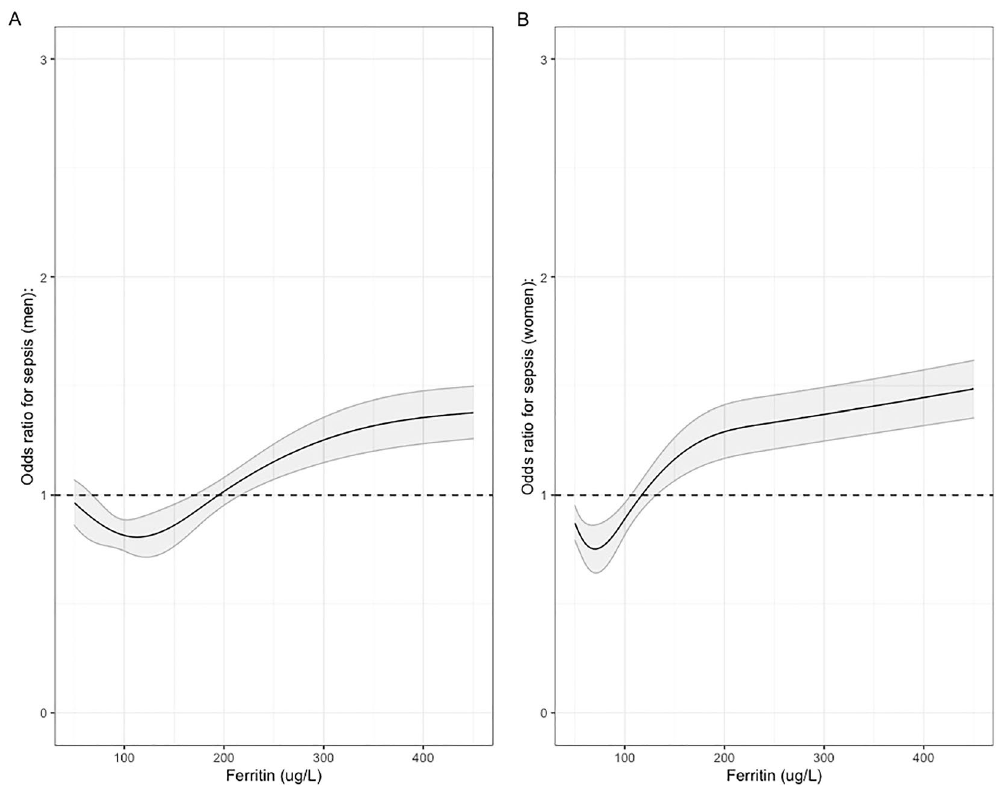
Figure 2. Odds ratios for sepsis with increasing ferritin between 50 and 450 ug/L, with the dashed line representing an odds ratio of 1, a null association.